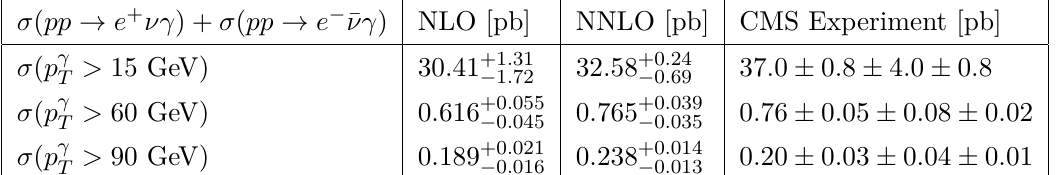
√ Table 6 . NLO and NNLO predictions for cross sections at s = 7 TeV, for comparison with the values measured by the CMS experiment [41]. The experimental result is the average of the cross section to electrons and the cross section to muons. The errors on the experimental results are statistical, systematic and luminosity respectively. All results have a cut ∆ R lγ > 0 . 7